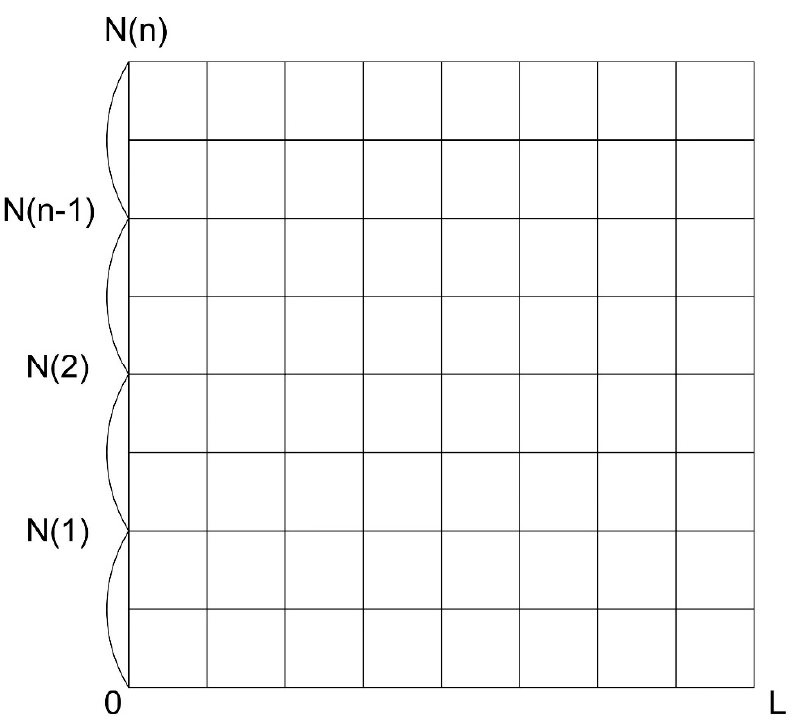
Figure 3. Scheme of parallelization of the calculation along the N axis.